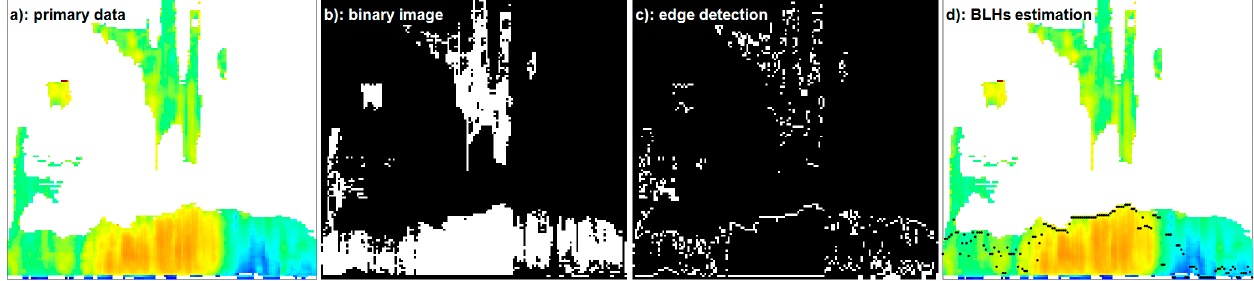
Figure 2. BLHs estimated by the ED method.